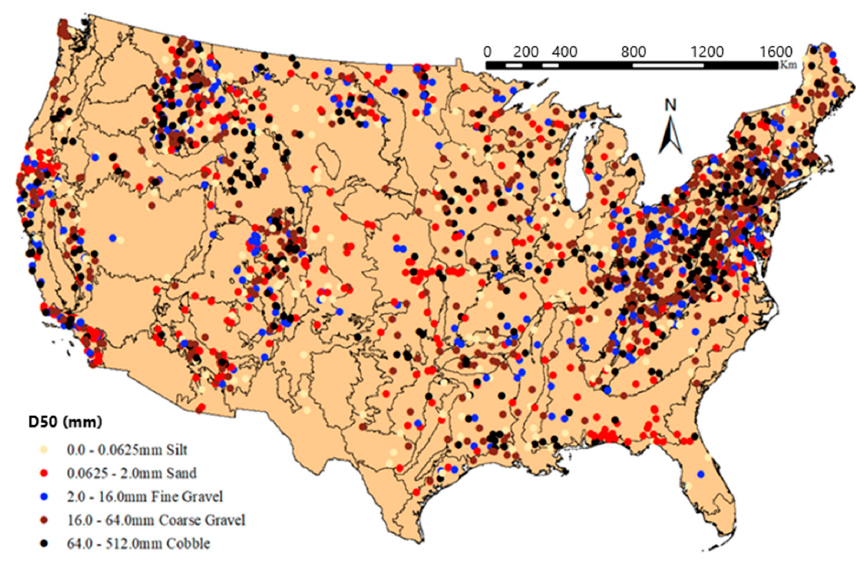
Figure 4. Distribution of D50 data points over Level III Ecoregions.